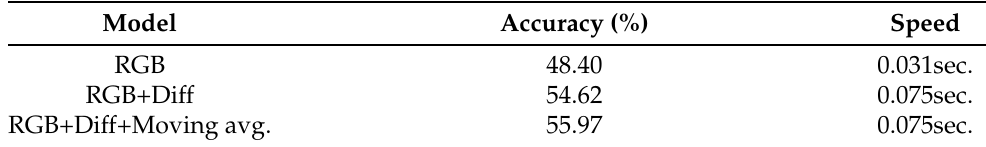
Table 5. Computational complexity